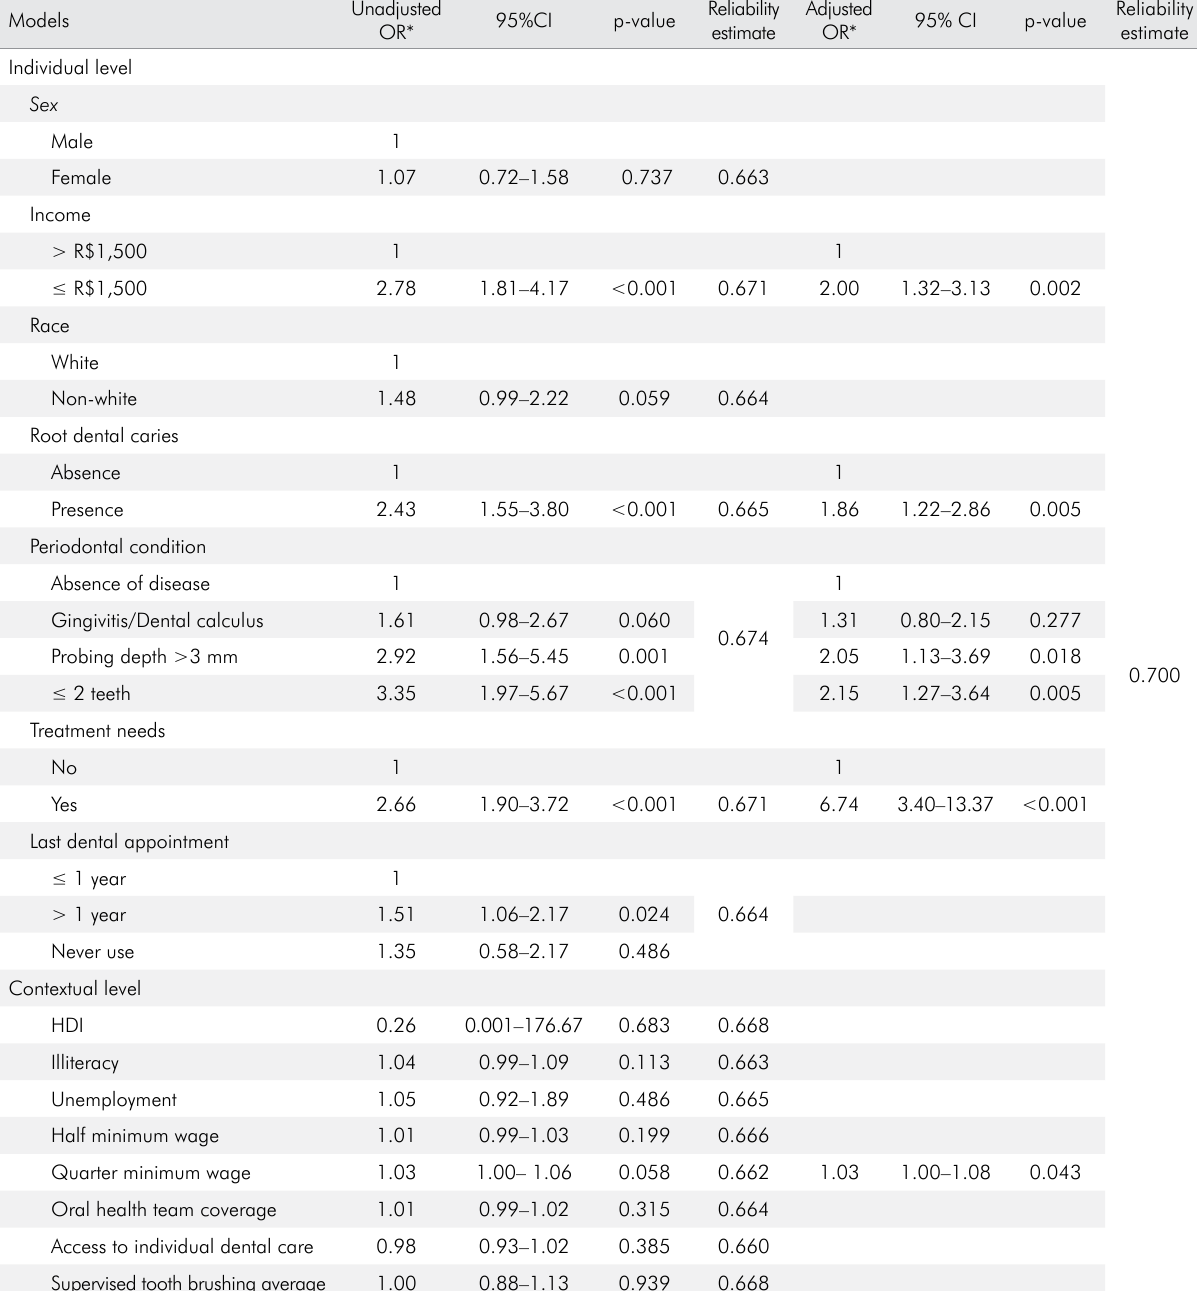
Table 5. Multilevel models (unadjusted and adjusted) for variables of individual (n = 1,1. 1) and contextual levels associated with toothache in adults from Minas Gerais, Brazil,